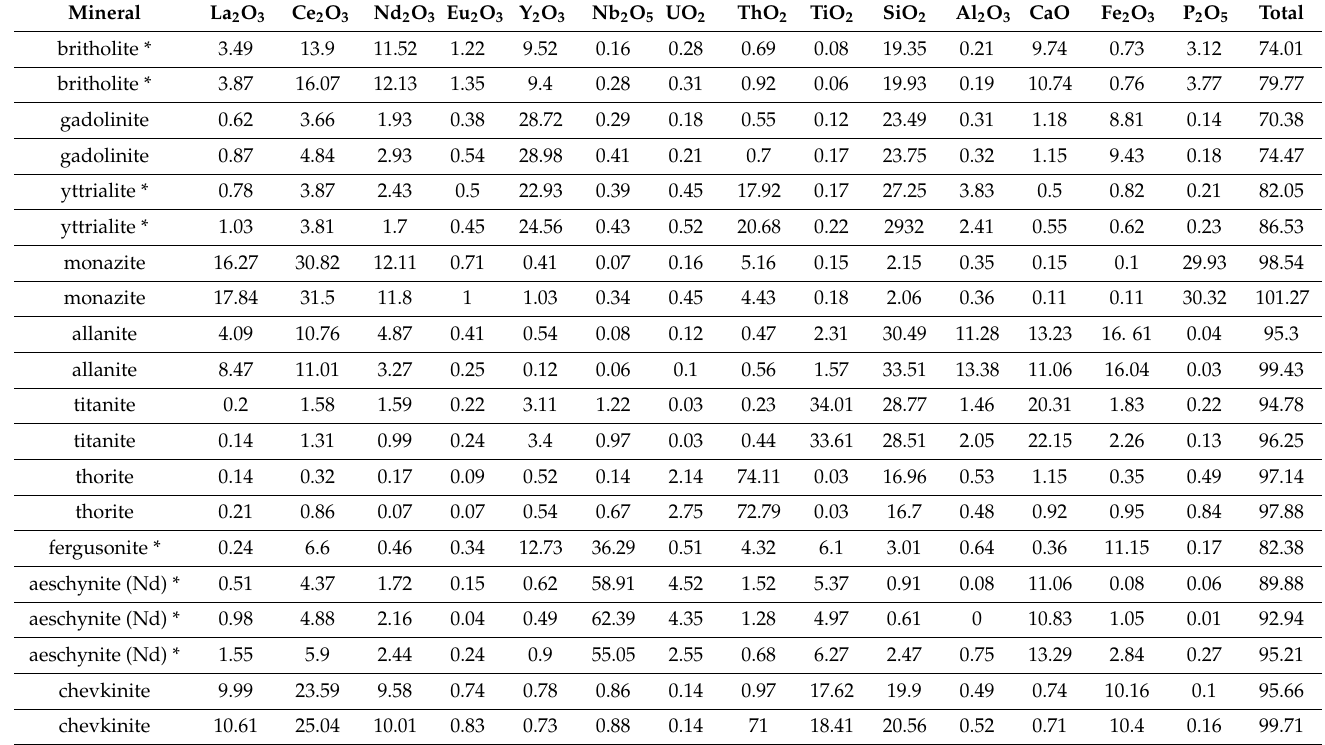
Table 2. Composition of main ore minerals of the Tommot deposit (in